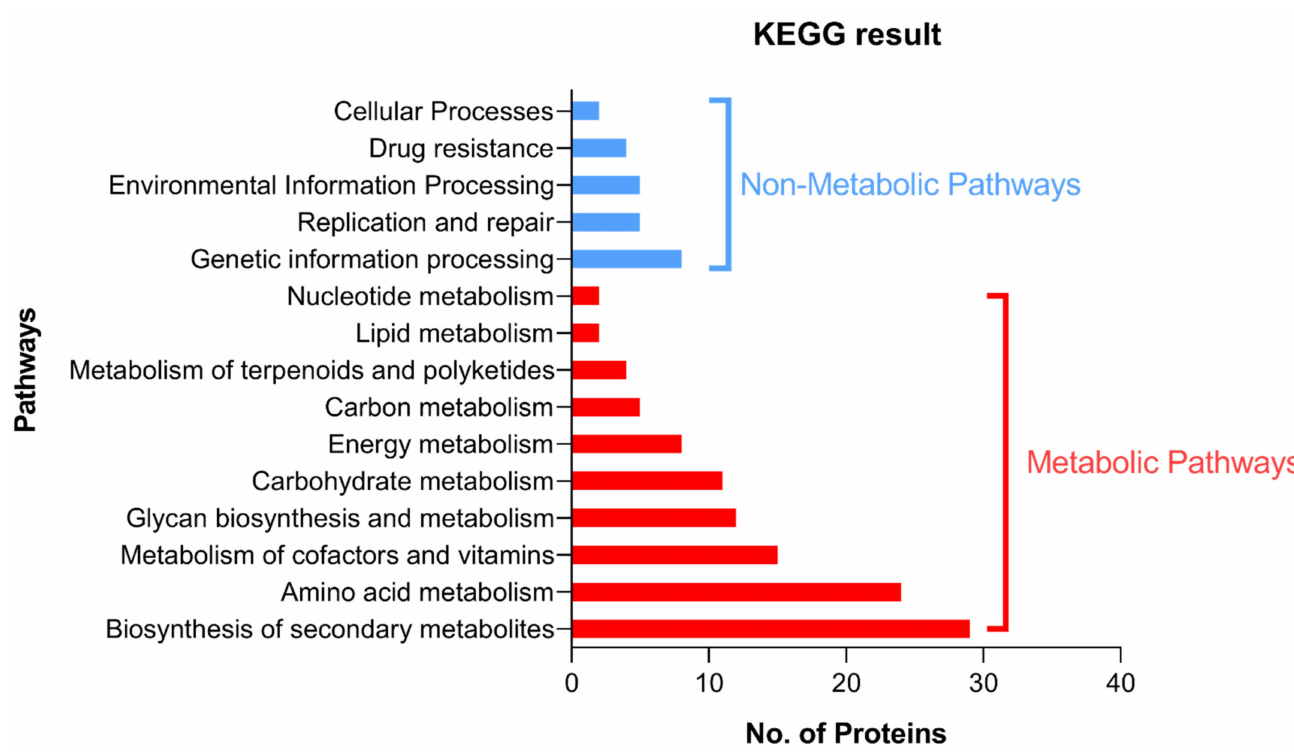
Figure 2. A diagram showing the distribution of the targeted proteins in different pathways. Blue bars represent the abundance of the proteins in different non-metabolic pathways and the red bars represent the abundance of the targeted proteins in different metabolic